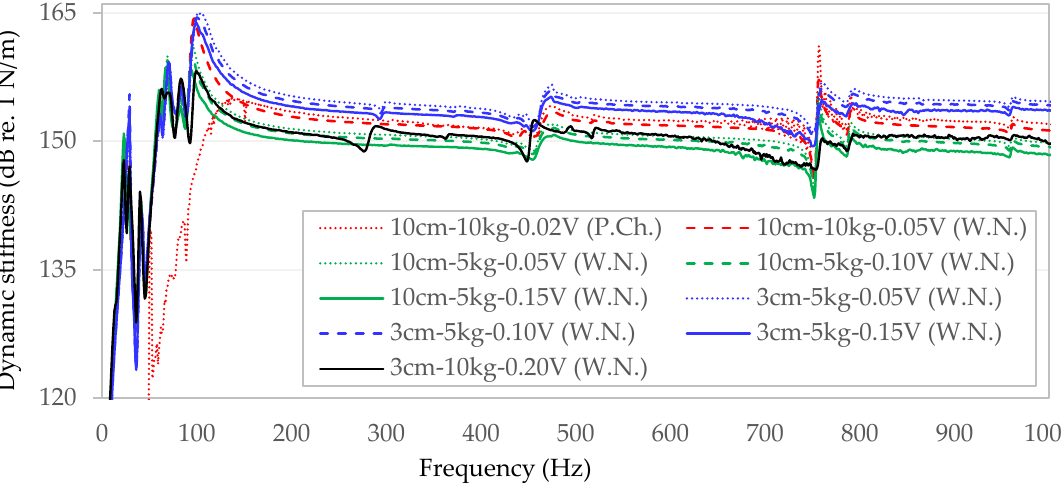
Figure 3. Dynamic stiffness over frequency for samples S1 considering varying load surface, static load level and vibration amplitudes (the legend used in brackets indicates the applied vibration excitation method: W.N.—white noise, P.Ch.—periodic chirp).